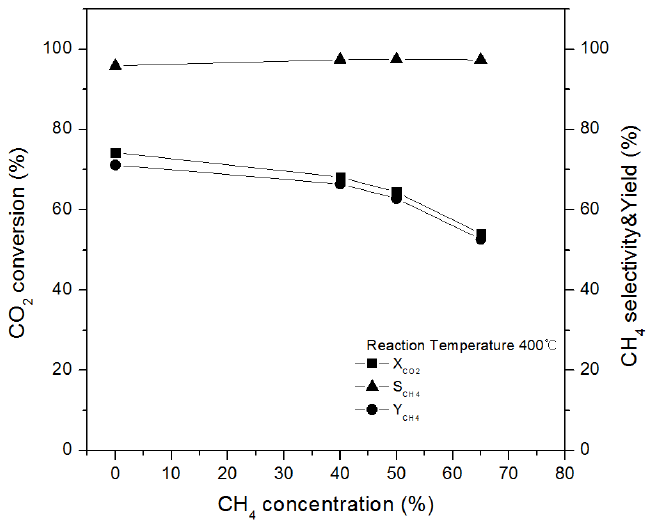
ff ect of initial CH 4 content in the reactant Figure 4. Effect of initial CH 4 content in the reactant gas. Figure 4. E